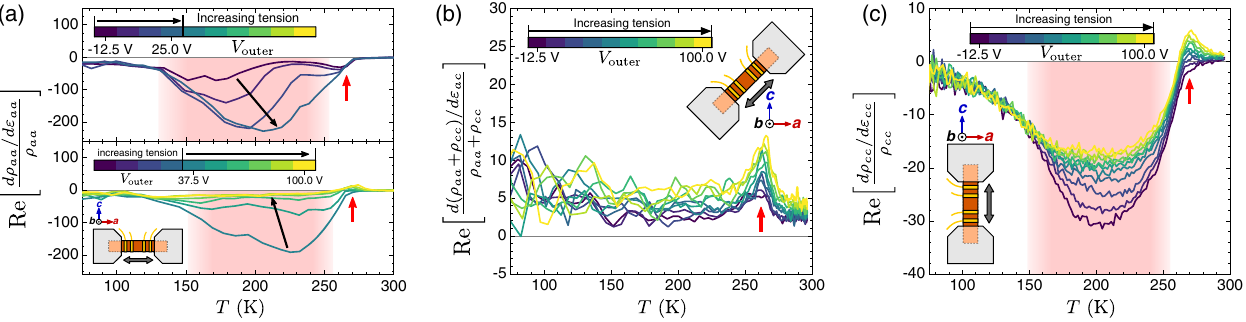
FIG. 8. (a) – (c) Longitudinal elastoresistivity components for ErTe 3 under three different stress orientations, as functions of temperature and PZT voltage. The results from the a -axis sample are split into two subpanels for clarity. Insets describe the orientation of the sample and current in each experiment. In the cases of a -axis and c -axis alignment, increasing tensile strain initially causes the growth of a large negative bulge (shaded in pink) between approximately 150 and 265 K, which then increases again for PZT voltages 37.5 Vand above. The behavior in the bottom panel of (a) mimics that of (c), where tensile c -axis stress also decreases the magnitude of this negative bulge in the same temperature range. Diagonal stress, as shown in (b), does not generate − ε any such response, indicating that the antisymmetric strain component ε dominates the changes in resistivity. A peak or dip aa cc localized at T (shown by the red arrow) appears in all three sample orientations although it carries the opposite sign for CDW 1 compressive and small tensile a -axis stress in the top panel of (a). This must therefore arise from the coupling of the CDW order parameter fluctuations to the in-plane symmetric strain or out-of-plane strain